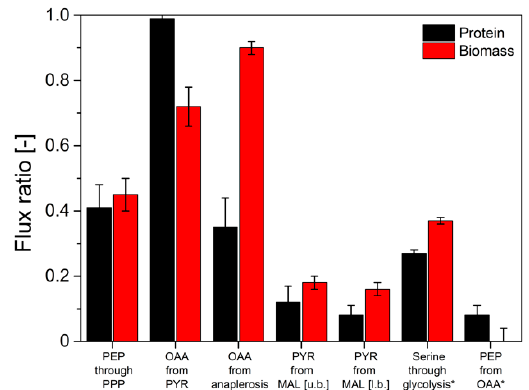
Figure 6. Comparison of intracellular flux ratios of H. polymorpha RB11 conphys in aerobic batch culture determined based on 13 C-isotope mapping in amino acids from secreted protein and biomass with METAFoR analysis. The first five ratios were determined from labeling experiments with 20% (mol/mol) U- 13 C glucose, and 80% (mol/mol) naturally labeled glucose as a sole carbon source at a total concentration of 5 g L − 1 . Ratios marked with an asterisk were calculated from labeling experiments with 5 g L − 1 100% (mol/mol) 1- 13 C-glucose. (PEP = phosphoenolpyruvate, PPP = pentose phosphate pathway, OAA = oxaloacetate, PYR = pyruvate, MAL = malate, u.b. = upper bound, l.b. = lower bound).